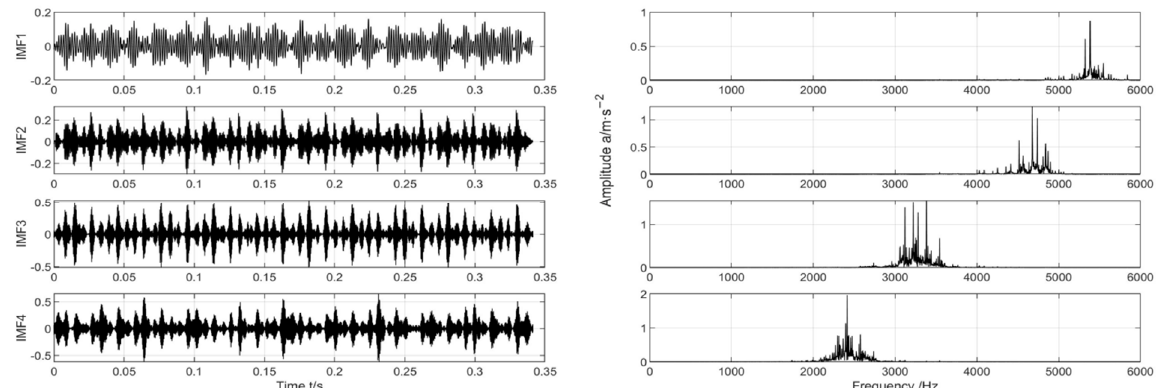
Figure 12. Time domain and frequency domain diagrams of IMF components decomposed by traditional VMD.